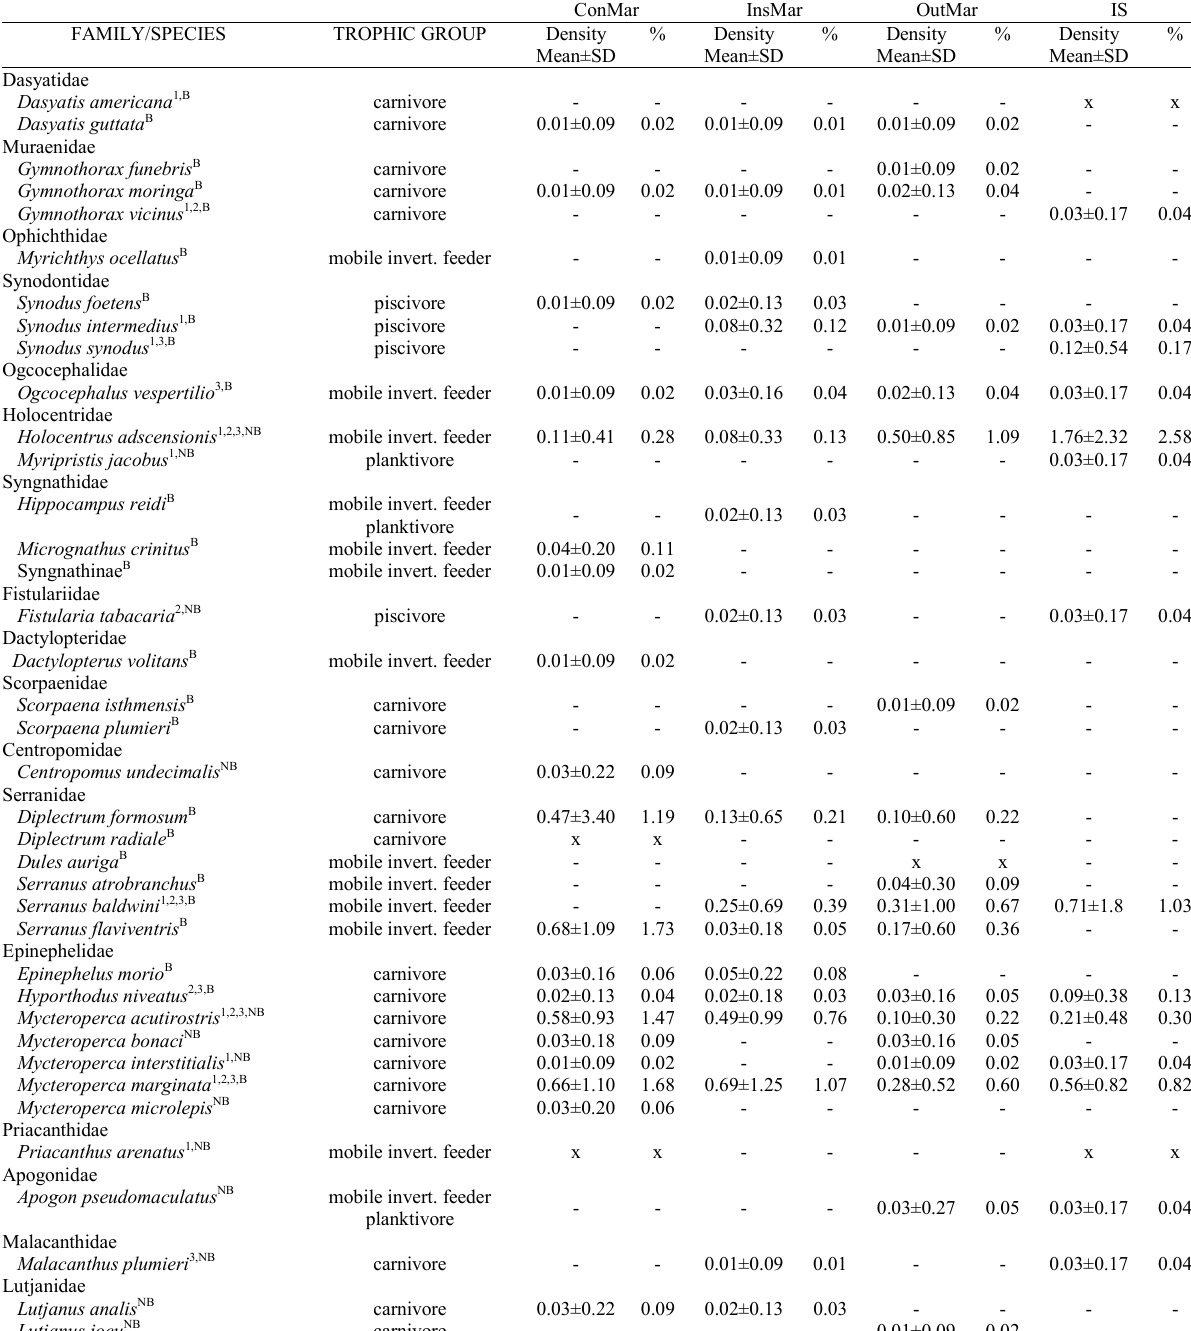
Table 1. Rocky shore fish fauna recorded in the study region and quantitative summary for each stratum. ConMar = Continental Margin of the São Sebastião Channel; InsMar = Insular Margin of the São Sebastião Channel; OutMar = Outer Margin of São Sebastião Island; IS = islands (Alcatrazes, Búzios and Vitória). Systematic order follows Nelson (2006), Craig & Hastings (2007) and Smith & Craig (2007). Species in bold type were not observed during the censuses. Trophic groups based in data from underwater observations and stomach content analysis in Gibran & Castro (1999), Gibran (2007) and Pires & Gibran (2011), and additional literature (Randall, 1996; Carvalho-Filho, 1999; Santos, 2005) - but see Ferreira et al. (2004) for categories’ details. Species observed only during the collecting activities, photo or video records are marked with an “x” (presence) or “-” (absence). Species recorded for each of the three islands or at another locality inside the study area are discriminated with superscripts (Alcatrazes 1 , Búzios 2 , Vitória 3 , Farol dos Moleques 4 , and Channel buoys 5 - see Fig. 1 for a map). Species are also discriminated with superscripts by their positions in the water column: benthic B or nektobenthic NB